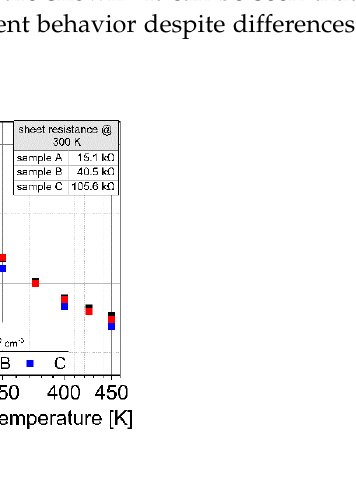
Figure 1. ( a ) Measurement temperature dependence of normalized average sheet resistance R sh ; ( b ) Determined effective acceptor ionization energies ∆ E A